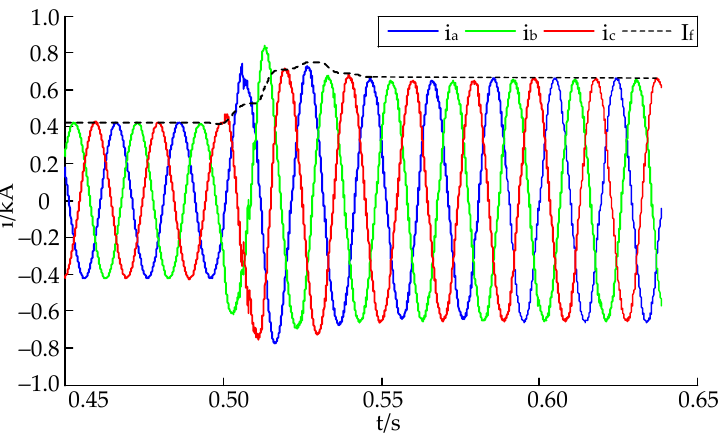
Figure 5. Tested instantaneous values and theoretical amplitude values of short-circuit current provided by PV station.